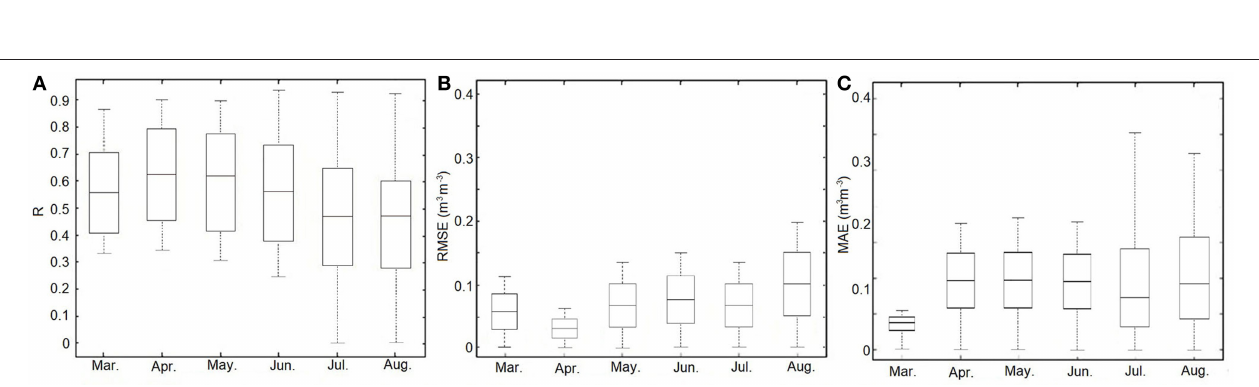
FIGURE 9 | Boxplot of three statistical indices (i.e., R, RMSE, and MAE) between the estimated SM and in situ SM. (A) R, (B) RMSE, and (C) MAE.